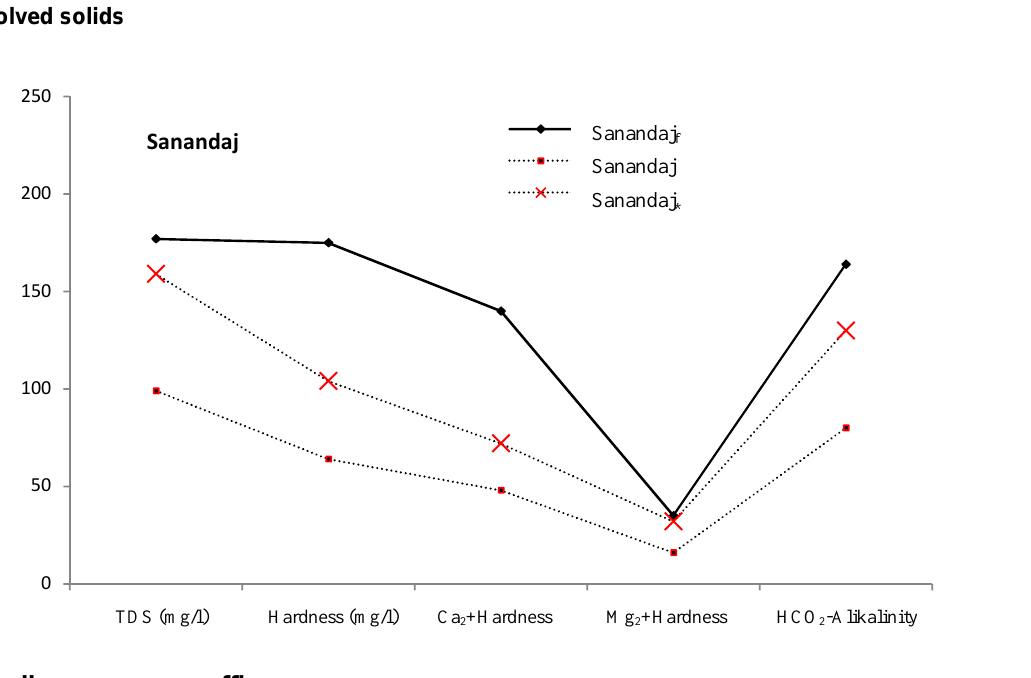
Figure 5. Neutralizer accessory efficiency TDS: Total dissolved